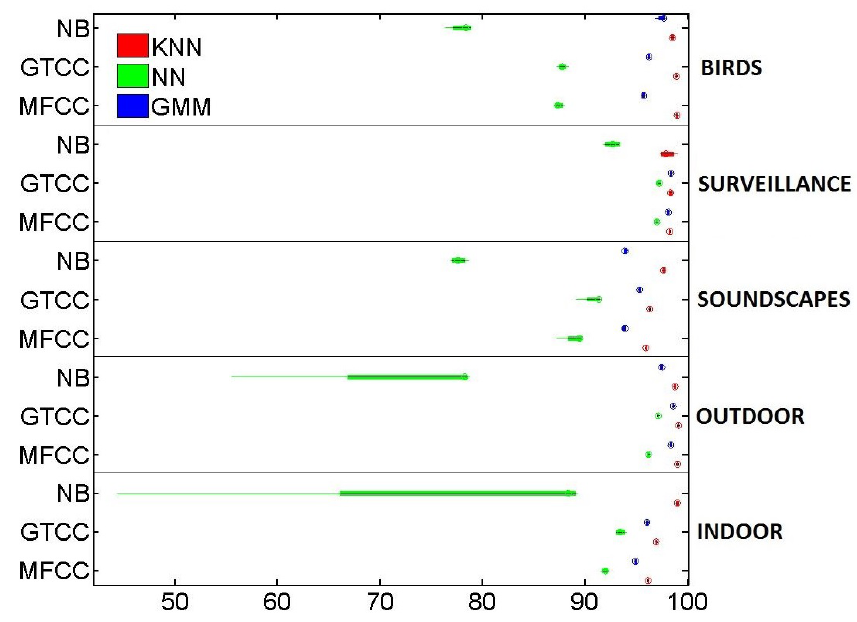
Figure 3. Boxplot of the detailed Accuracy’s Mean and Variance in the 4-fold